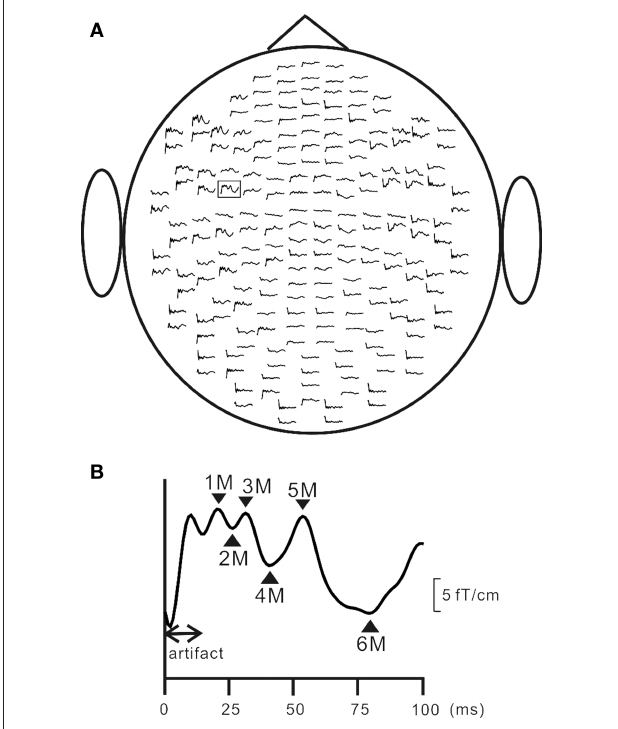
FIGuRE 2 | Grand averaged MEG signals for the right anterior (RA) stimulation of the tongue. (A) The SEF waveforms over 204 planar coils from the top of the head. (B) An enlarged waveform recorded in the left centrotemporal areas, which was framed by a square in (A) . Adopted from Sakamoto et al. (2008a).